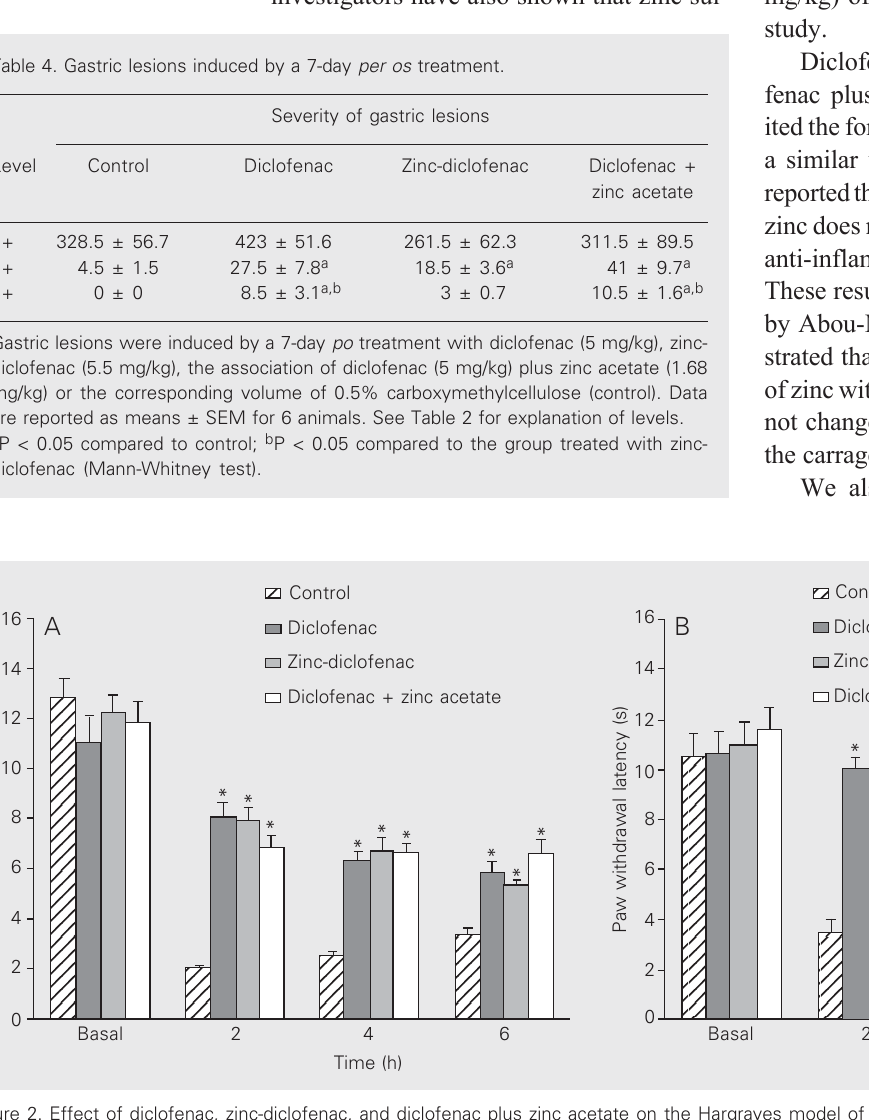
Figure 2. Effect of diclofenac, zinc-diclofenac, and diclofenac plus zinc acetate on the Hargraves model of nociceptive response after per os (A) and intraperitoneal administration (B). Diclofenac (10 mg/kg), zinc-diclofenac (11 mg/kg), the association of diclofenac (10 mg/kg) plus zinc acetate (3.35 mg/kg) or the corresponding volume of 0.5% carboxymethylcellulose (control) was administered 2 h before injection of 1% carrageenin into the subplantar region of the left hind paw. Data are reported as means ± SEM for 6 animals. Basal corresponds to the latency for paw withdrawal before the treatments. *P < 0.05 compared to control (ANOVA and Duncan